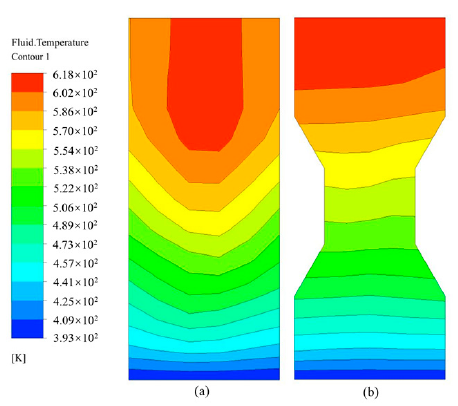
Figure 5. Cooling gas temperature distribution. ( a ) case 0; ( b ) case 1.